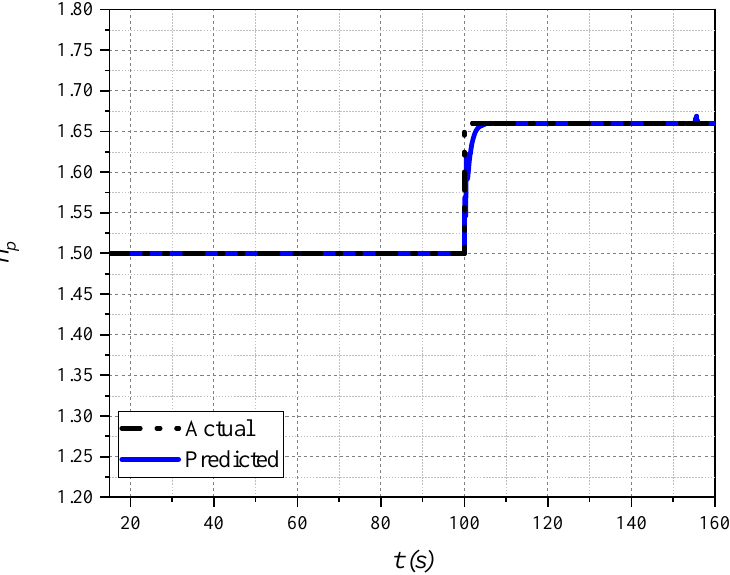
Figure 19. Predicted and actual microgrid load n p